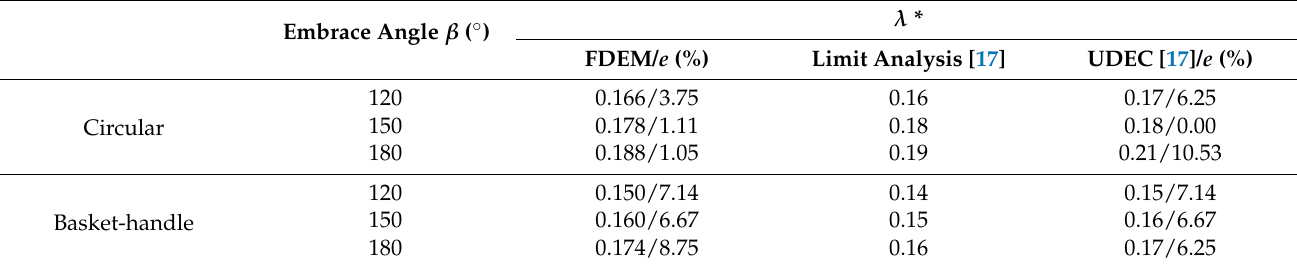
Table 3. λ * of buttressed circular and basket-handle masonry